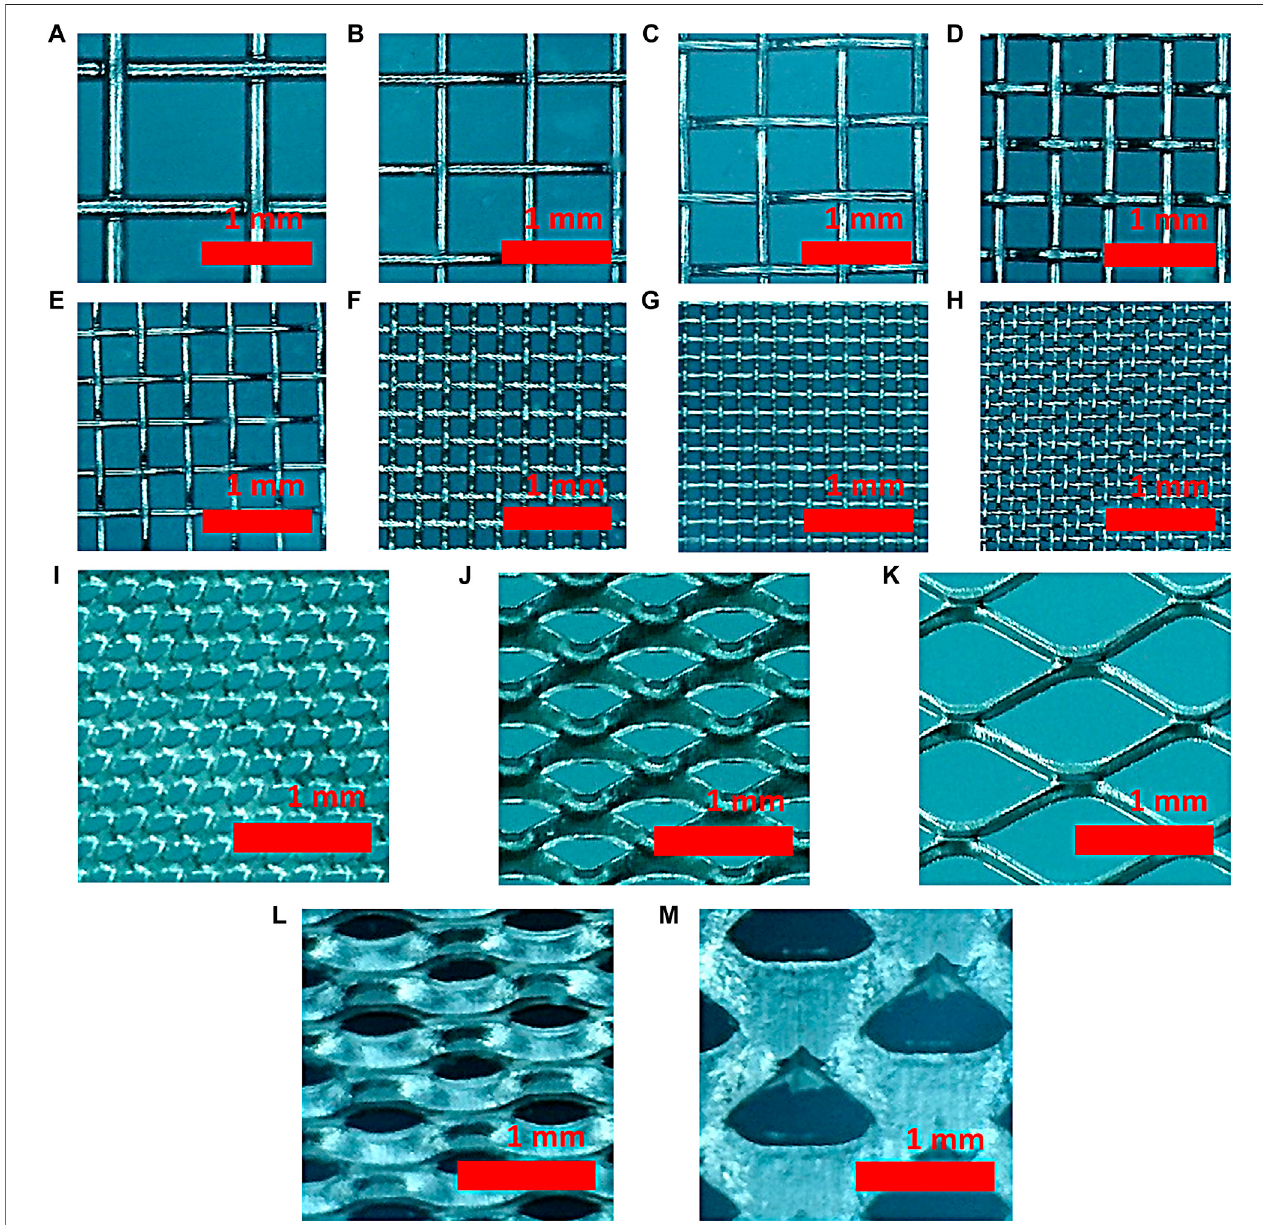
FIGURE1| Opticalmicroscopicimageof (A) 20, (B) 30, (C) 40, (D) 50, (E) 60, (F) 100, (G) 150,and (H) 200wovenmeshand (I) 2Ni-031, (J) 4Ni4-077, (K) 5Ni10- 125, (L) 7Ni10-050, and (M) 7Ni17-080 expanded mesh samples.